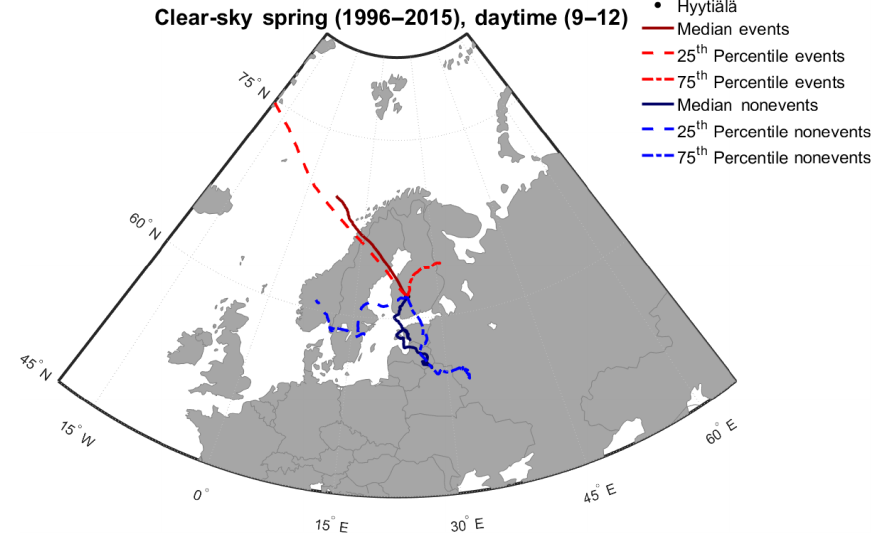
Figure 4. Median and percentiles of 96h backward air mass trajectories arriving at Hyytiälä during springtime